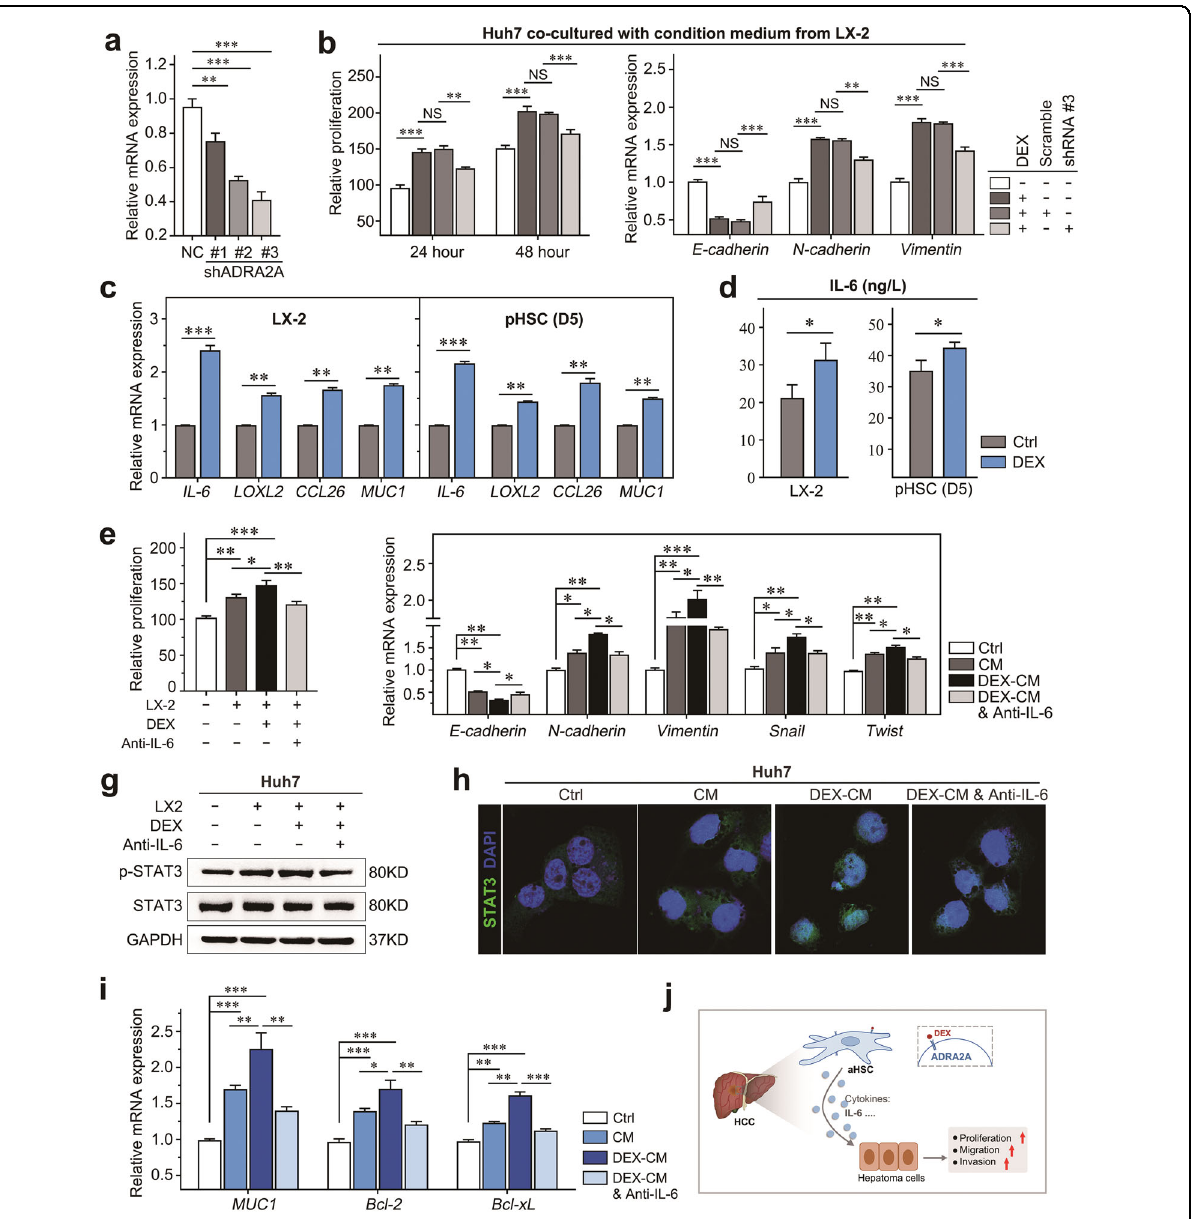
Fig. 6 DEX induced tumor-promoting cytokine and chemokine secretion from aHSCs to promote HCC proliferation, metastasis, and STAT3 activation. a The expression of ADRA2A in LX-2 cells was detected by RT-PCR. b The proliferation ratio (left panel) and EMT-related biomarker expression (right panel) in Huh7 cells measured by CCK-8 and RT-PCR, respectively. c Changes in cytokine and chemokine ( IL-6 , LOXL2 , CCL26 , MUC1 ) mRNA levels in LX-2 or primary aHSCs treated with DEX. d The concentration of IL-6 in the culture supernatant was measured by ELISA after 48 h of DEX (10 μ M) treatment. e The proliferation ratio of Huh7 cells was detected by CCK-8. f The mRNA levels of the indicated EMT-related biomarkers in Huh7 cells were investigated by RT-PCR. g Huh7 cells were inoculated in monoculture or in HSC CM or exposed to 100 ng/ml IL-6 neutralizing antibody. The protein levels of STAT3 and p-STAT3 in Huh7 cells were detected after 48 h inoculation. h Representative images of STAT3 changes in Huh7 cells from the indicated groups were investigated by confocal microscopy. i Changes in the mRNA levels of STAT3 downstream molecules ( MUC1 , Bcl2 , Bcl-xL ) in Huh7 cells were investigated by RT-PCR. j Graphical abstract illustrating the key concept that DEX induces IL-6 secretion from activated HSCs, which promotes the proliferation, migration, and invasion of HCC cells. Data are presented as the mean ± SD. * P < 0.05; ** P < 0.01; *** P <